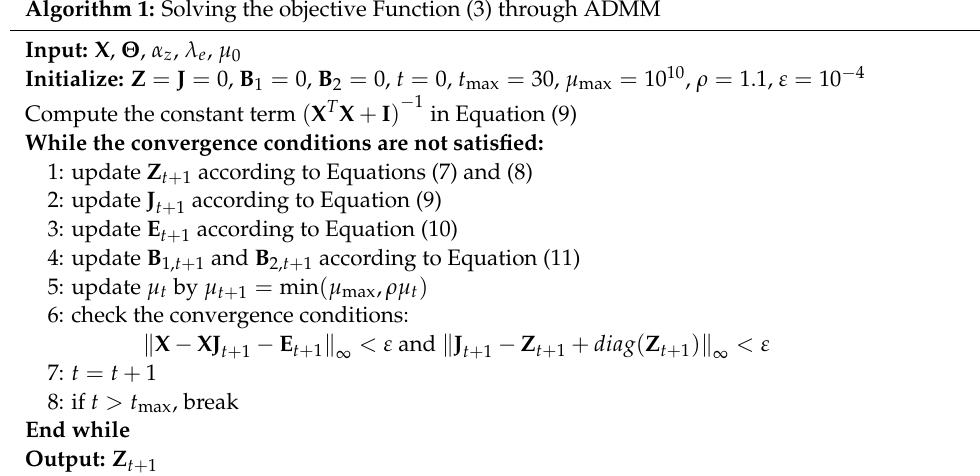
Algorithm 1: Solving the objective Function (3) through